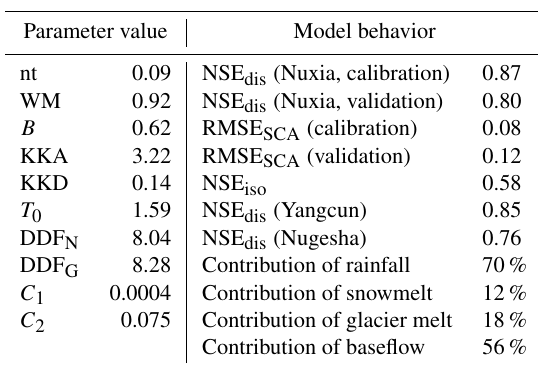
Table 5. Benchmark parameter set and corresponding model be- havior that are used to produce stream water δ 18 O data for model calibration in Experiment 3 in the YTR